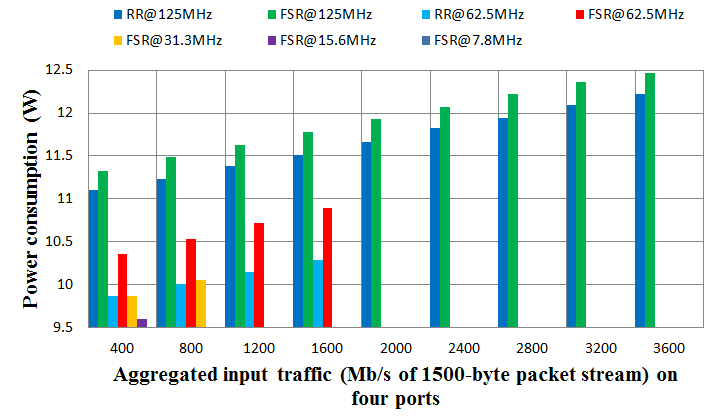
Figure 10. Power consumption of the RR and the FSR under different frequencies and traffic bit rates.